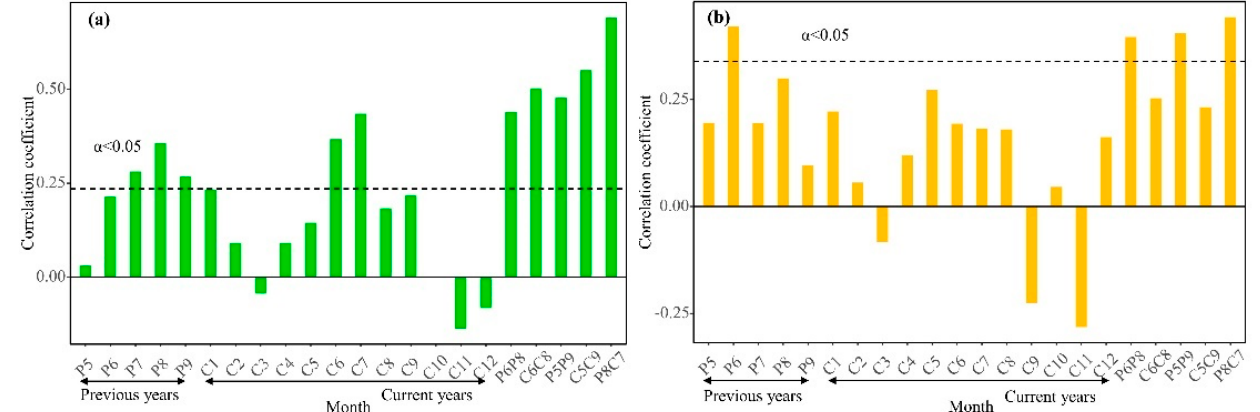
Figure 5. Correlation analysis between the Ring Width Index (RWI), NDVI, and precipitation. Correlation between the RWI and precipitation ( a ); correlation between the NDVI and precipitation ( b ). The horizontal dashed line is the 95% confidence line; Previous year refers to the correlation of precipitation in the previous year, and the month is represented by P; Current years is the correlation of the precipitation in the current year, and the month is represented by C; the alphanumeric combination in the month combination letter represents the year, and the number represents the month.